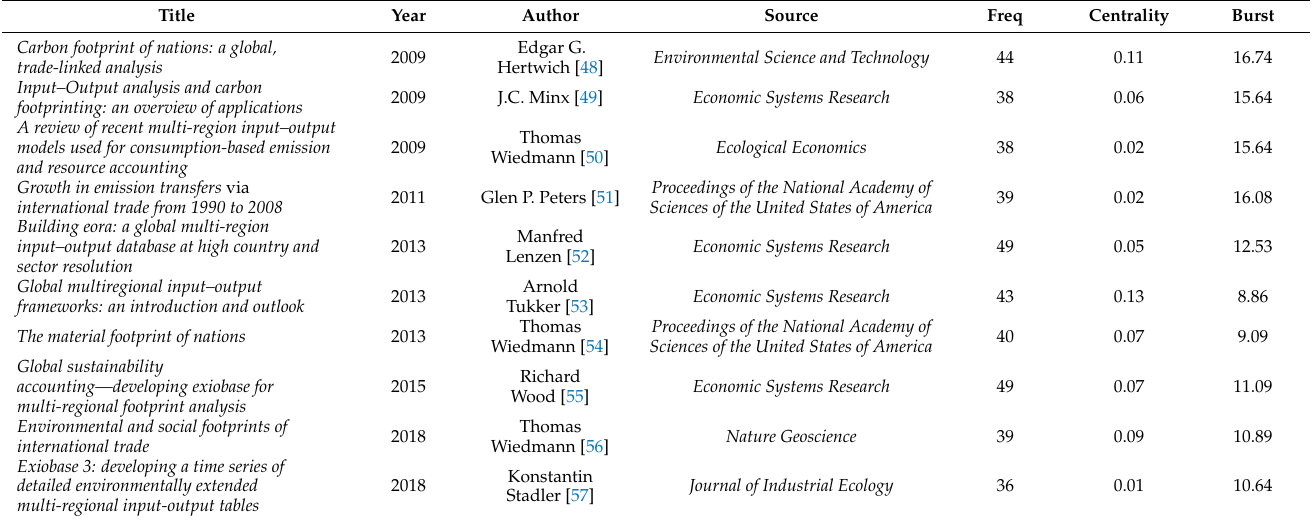
Table 4. The top 10 cited articles with high co-citation frequency and betweenness